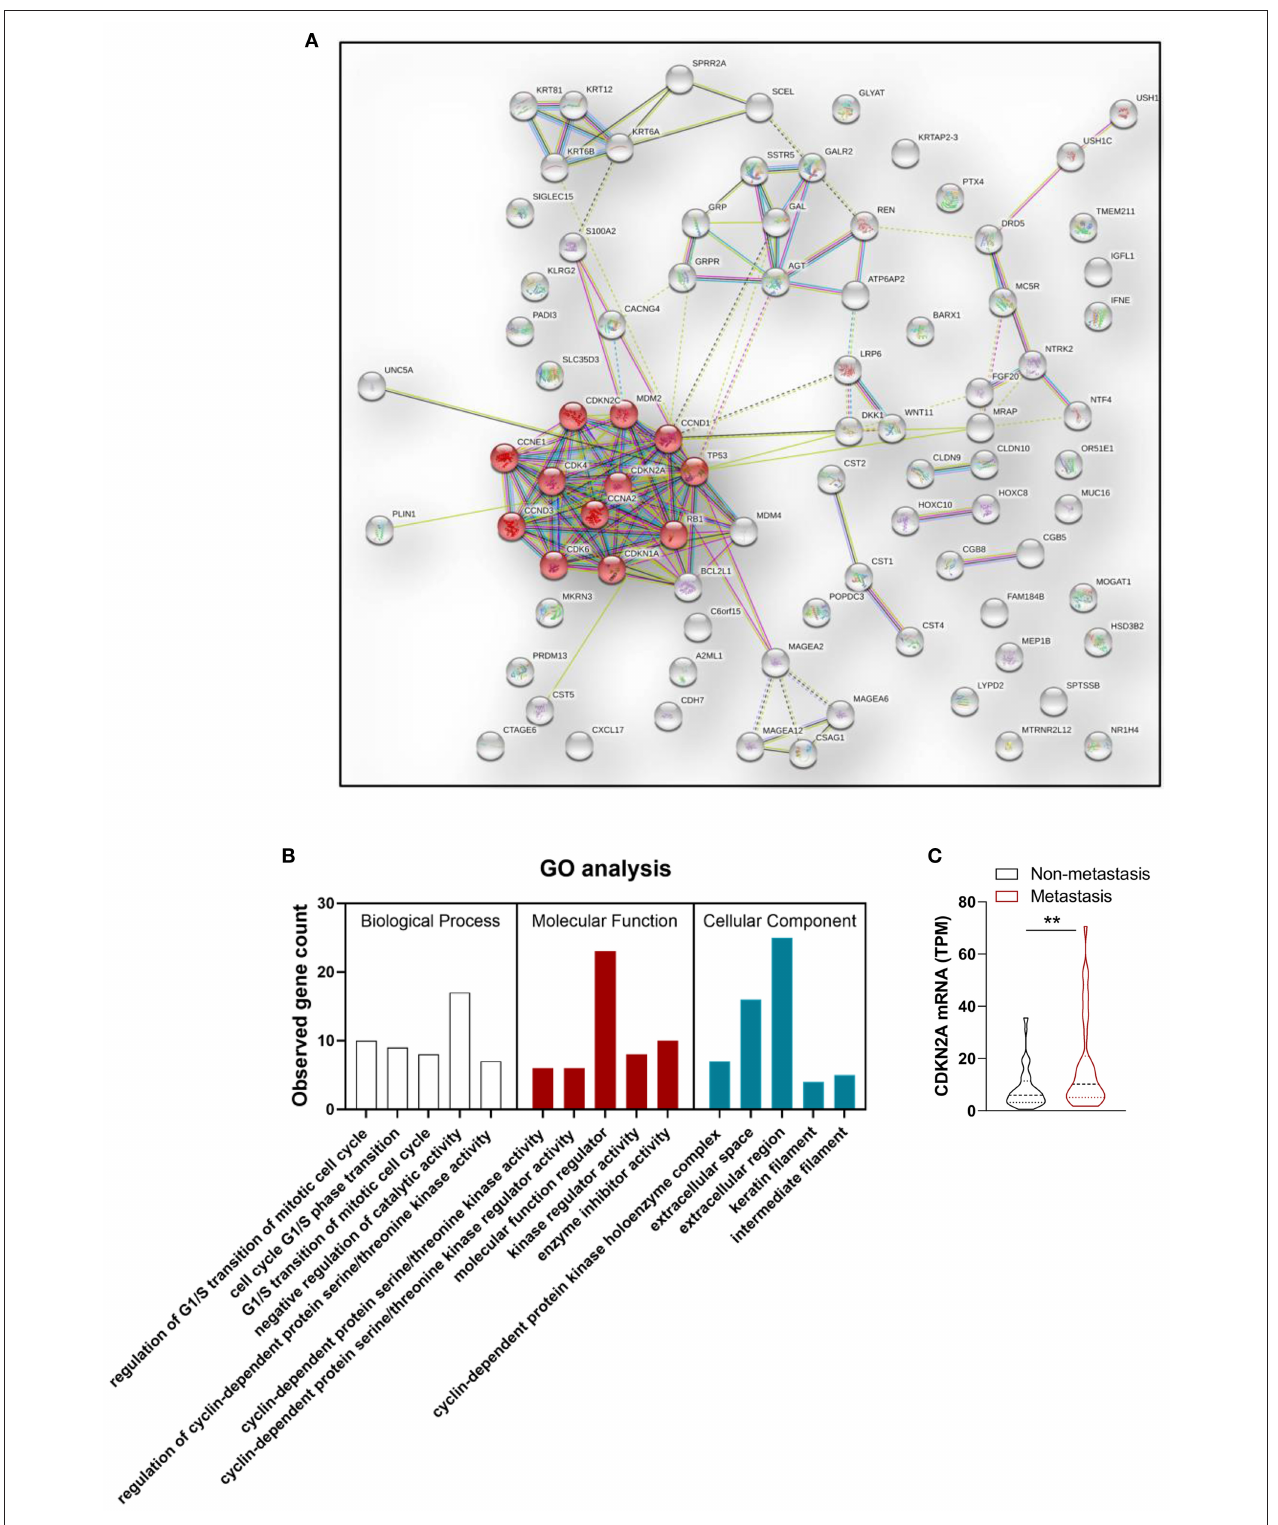
FIGURE 3 | Genomics features selection. (A) Protein–protein interaction (PPI) network and (B) Gene Ontology (GO) enrichment analysis of differentially expressed genes between metastasis group and non-metastasis group. Red node represents proteins enriched in cell cycle pathway. (C) Statistical analysis of CDKN2A mRNA expression level in metastasis group and non-metastasis group. n = 90. ** P < 0.01.